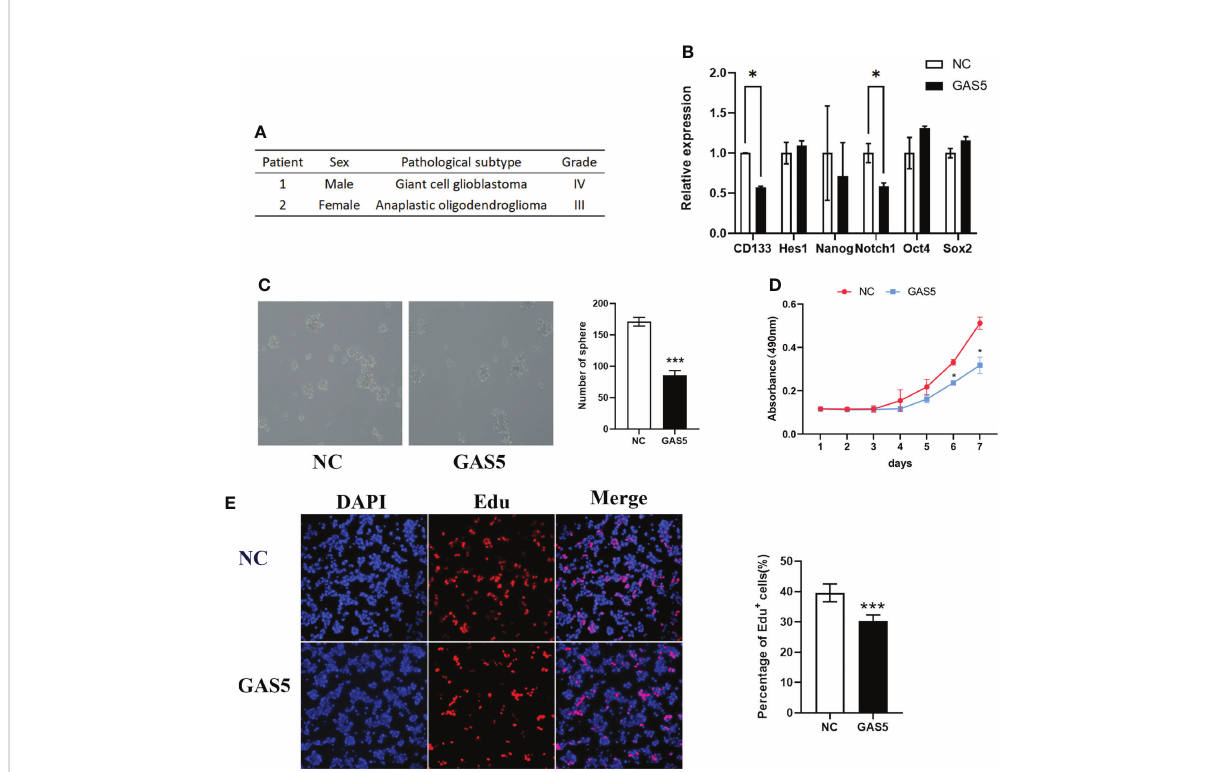
FIGURE 3 LncRNA-GAS5 over-expression impairs the stemness and proliferation of GSCs. (A) Information from the two clinical specimens we used to induce glioma stem cells. (B) qRT-PCR analysis of the expression of several stem cell marker molecules in GAS5 overexpression and parental GSCs (n=3). GAPDH is used as a reference gene. (C) Tumor spheres formation assay showed the upregulation of GAS5 affected the number and size of tumorspheres (n=3). (D) CCK-8 assay revealed the effect of GAS5 overexpression on the proliferation of GSCs with the cells are cultured for seven consecutive days and the absorbance of the cells are measured daily (n=6). (E) EdU assay showed the effect of GAS5 overexpression on DNA replication activity of GSC (n = 3). Data are presented as the mean ± S.D. P value is determined by Student ’ s t test (*P < 0.05, ***P <